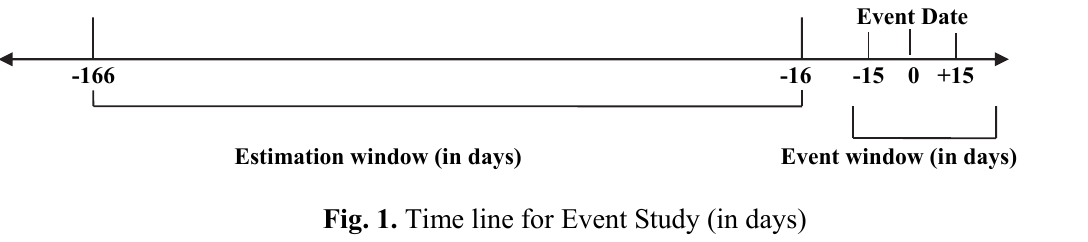
Fig. 1. Time line for Event Study (in